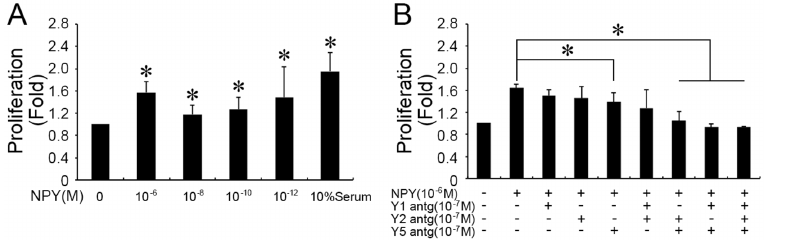
Fig 3. NPY stimulated the proliferation of cultured VSMCs, and the NPY receptors were involved in this process. (A) VSMCs were stimulated by NPY at different concentration for 24 hours. The last column showed 10% serum data ( n = 4). (B) VSMCs were pre-incubated with single or combinational NPY receptor antagonists (NPY 1, 2 and 5 receptor antagonists), and then treated with 10 − 6 mol/L NPY ( n = 4). Shown values are the mean ± SD , * P < 0.05 v . s . the respective control.